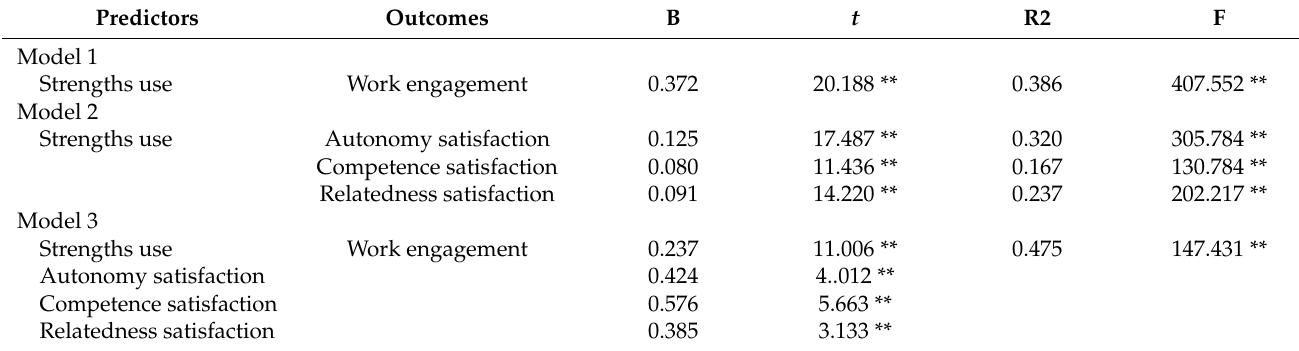
Table 2. Multiple regression analysis.